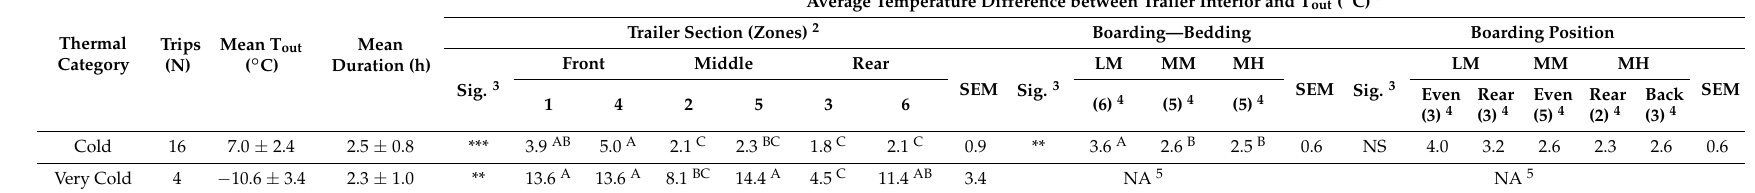
Table 4. Evaluation of the effects of trailer zones, bedding and boarding combination, and boarding position for 20 monitored transport trips categorized as thermal categories Cold and Very Cold